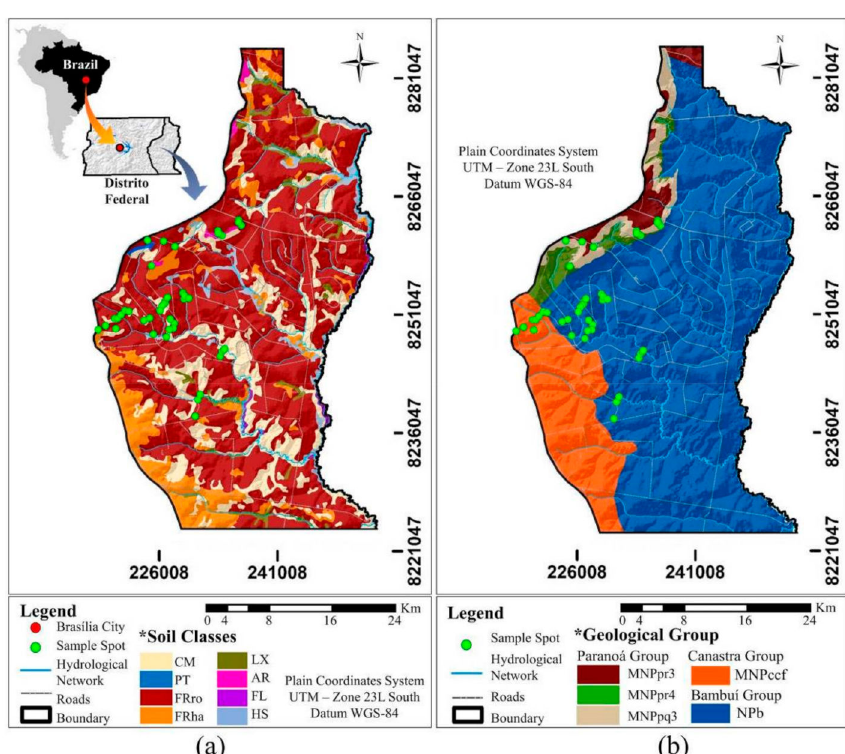
Figure 1. Soil ( a ) and geological ( b ) maps of the study area. The soil map was adapted from the World Reference Base [24]. CM: Cambisols; PT: Plinthosols; FRro: Rhodic Ferralsol; FRha: Haplic Ferralsol; LX: Lixisol; AR: Arenosol; FL: Fluvisol; HS: Hydromorphic soils; MNPpr3: sandy metarrythmits; MNPpr4: clayey metarrythmits; MNPpq3: quartzite; MNPccf: carbonated phyllite; and NPb: pelitic rocks. Sources: